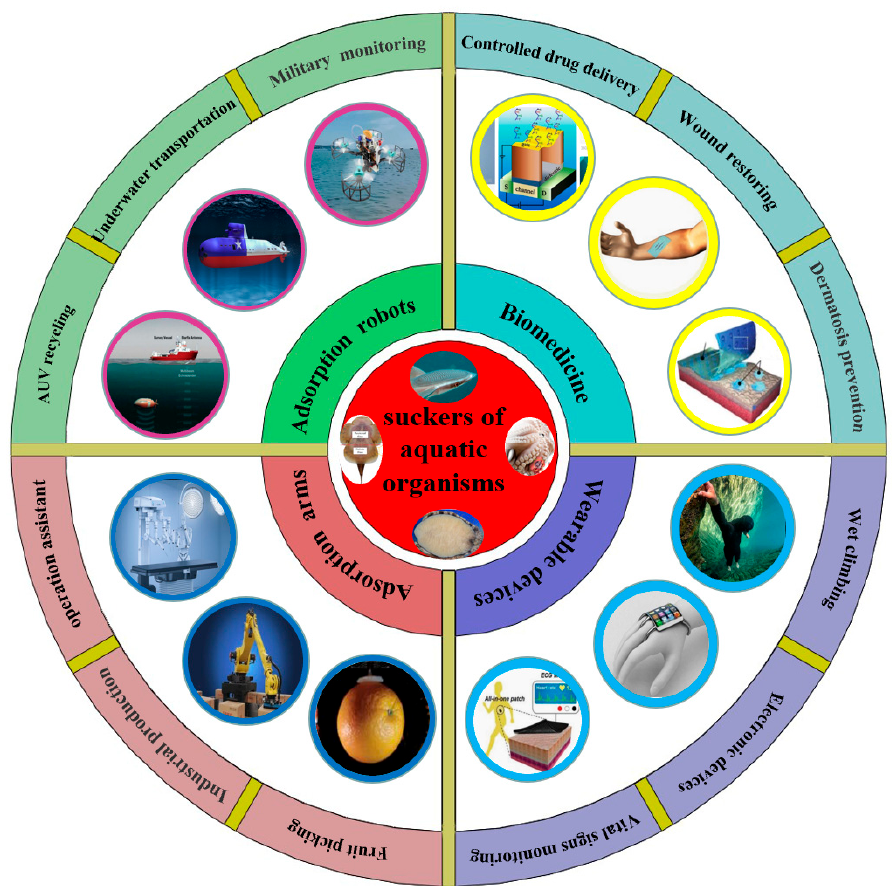
Figure 9. The application of biomimetic devices based on the attachment mechanism of suckers of aquatic organisms [61], which includes attachment robots (e.g., AUV recycling, underwater transportation, military monitoring, etc.), attachment arms (e.g., fruit picking, industrial production, operation assistant, etc.), biomedicine (e.g., controlled drug delivery, wound restoring, dermatosis prevention, etc.), and wearable devices (e.g., wet climbing, vital sign monitoring, electronic devices, etc.).